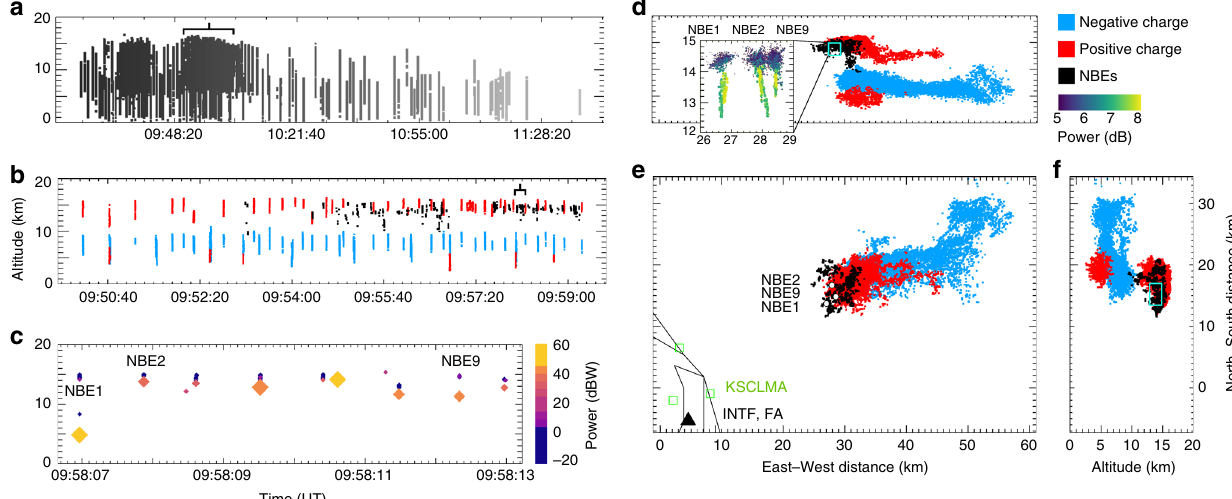
Fig. 1 Lightning mapping observations of the 24 August 2016 storm by the Kennedy Space Center Lightning Mapping Array. a Overview of the height-time evolution of the 3-h storm, b 10 min of enhanced activity during the bracketed interval of a , colored by the lightning-inferred polarity of the storm charge (red = upper and lower positive charge, blue = mid-level negative charge), showing the NBE events (black), c zoomed-in view of 6 s of high-rate NBE activity (~40 NBEs within 1 min), indicated by the bracket in b , colored and sized by VHF source power and showing NBEs 1, 2, and 9. Note that the initial high-power sources of the NBEs (large diamond markers) were mis-located in altitude from the subsequent, smaller, and correctly located lower-power sources (blue markers), with NBE 1 altitude being particularly incorrect (see Methods). The low-power sources indicate that all 10 NBEs occurred at similar altitudes between 13 and 15 km MSL, immediately below or within the inferred upper positive charge region. d – f Plan and vertical cross-section views of the storm charge structure, colored by charge as in b and showing that the NBEs occurred in close proximity to a positively charged western anvil of the normally electri fi ed storm. The inset in the east – west cross-section of d shows the full-duration INTF centroid observations for each of the three NBEs relative to the storm location, with marker colors corresponding to relative VHF power. The inset shows that each NBE had a vertical extent of ≃ 1.5 km on the lower edge of the upper positive charge region. The plan view of e shows the NBE locations as white circles. The cyan boxes in d and f indicate their locations in the vertical cross-sections. The black triangle in e indicates the INTF location at